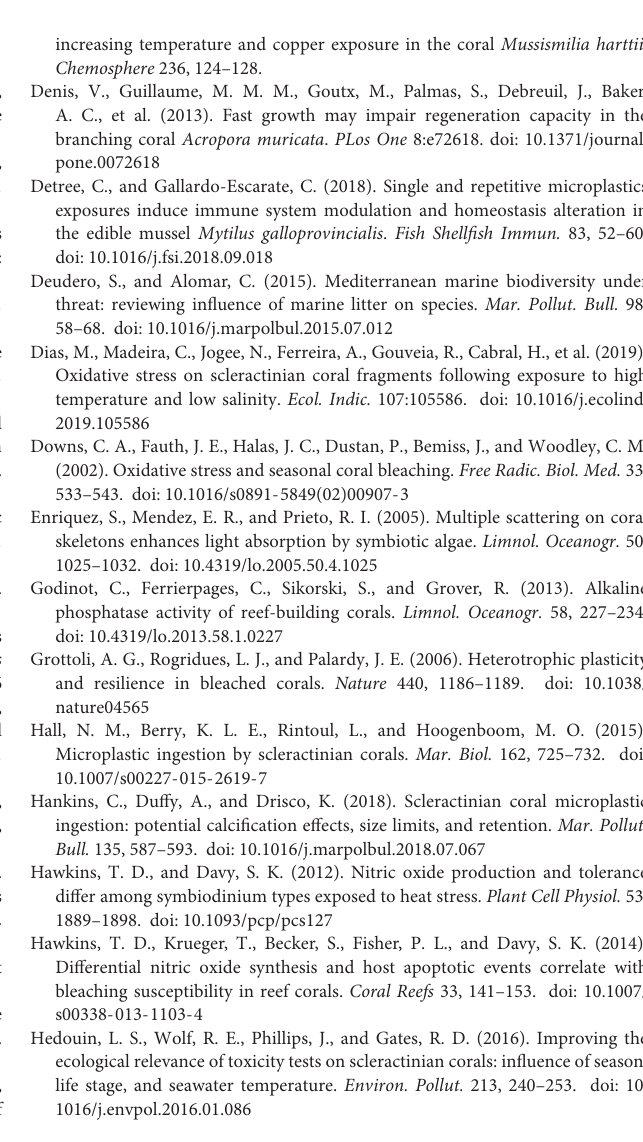
Supplementary Figure 1 | The microscope images and size distribution of three types of MPs (PET, PA66, PE). Supplementary Figure 2 | The coral reef field locations (22 ◦ 33 (cid:48) 50.78 (cid:48)(cid:48) − 22 ◦ 40 (cid:48) 38.18 (cid:48)(cid:48) N, 114 ◦ 30 (cid:48) 35.62 (cid:48)(cid:48) − 114 ◦ 33 (cid:48) 26.90 (cid:48)(cid:48) E) and sample ( Acropora